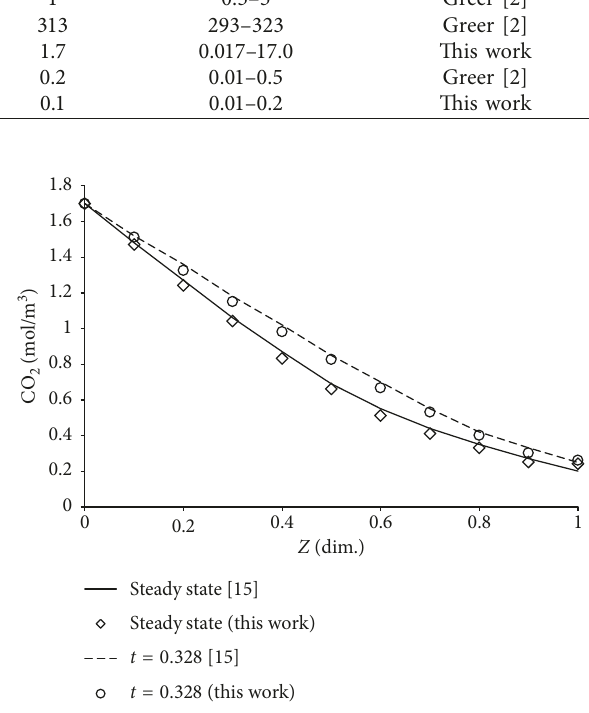
Figure 3: Comparison of carbon dioxide axial concentration profiles with literature data.